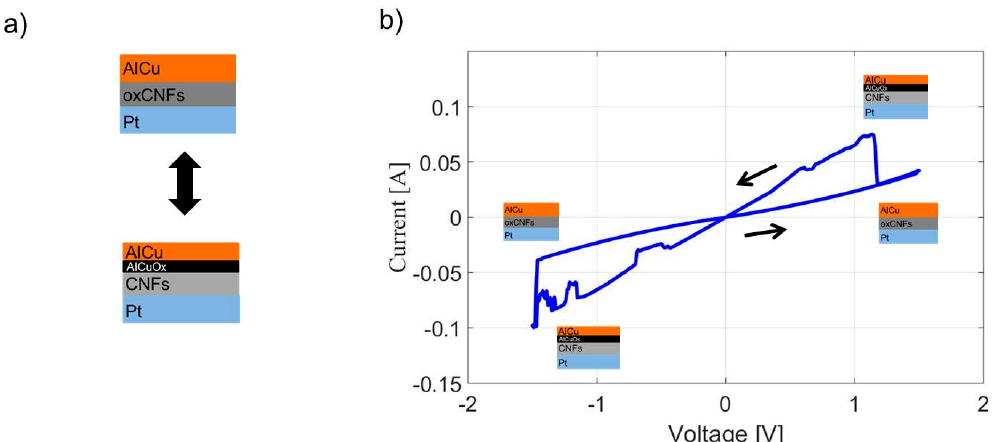
Figure 6. ( a ) The schematic side view of the two states of resistance of the memory stack ( b ) An image of a cycle obtained by applying a voltage between the inert Pt electrode and the AlCu electrode. The hysteretic change of current results from the migration of oxygen atoms between the carbon nanofiber (CNF) layer and the AlCu metal.